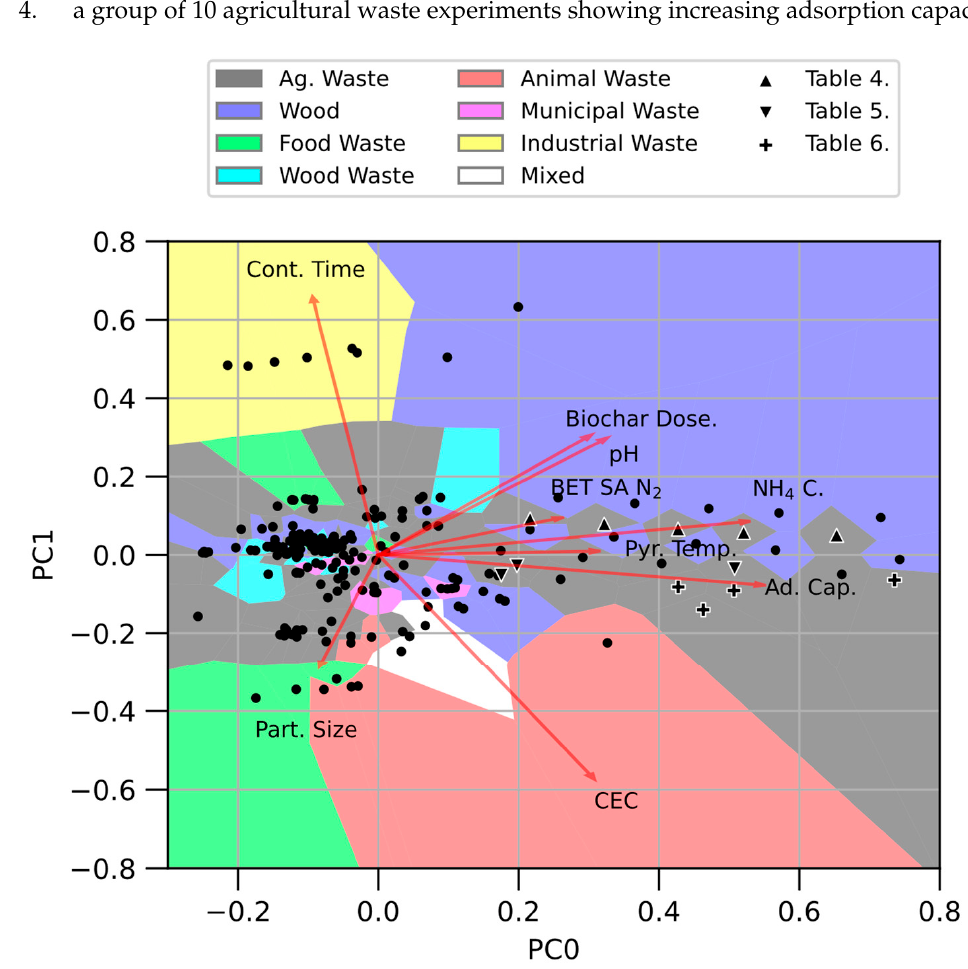
Figure 5. PCA biplot for all data by biochar material.